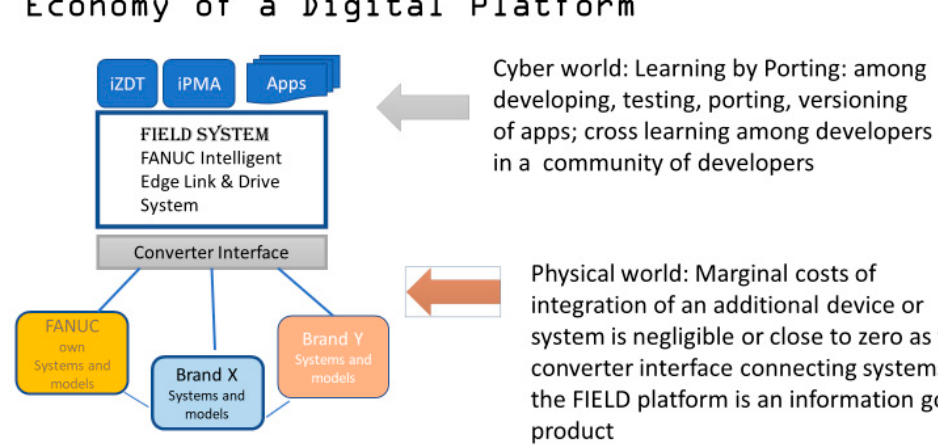
Figure 5. Illustrating the essential economies of an OPEN two-sided digital